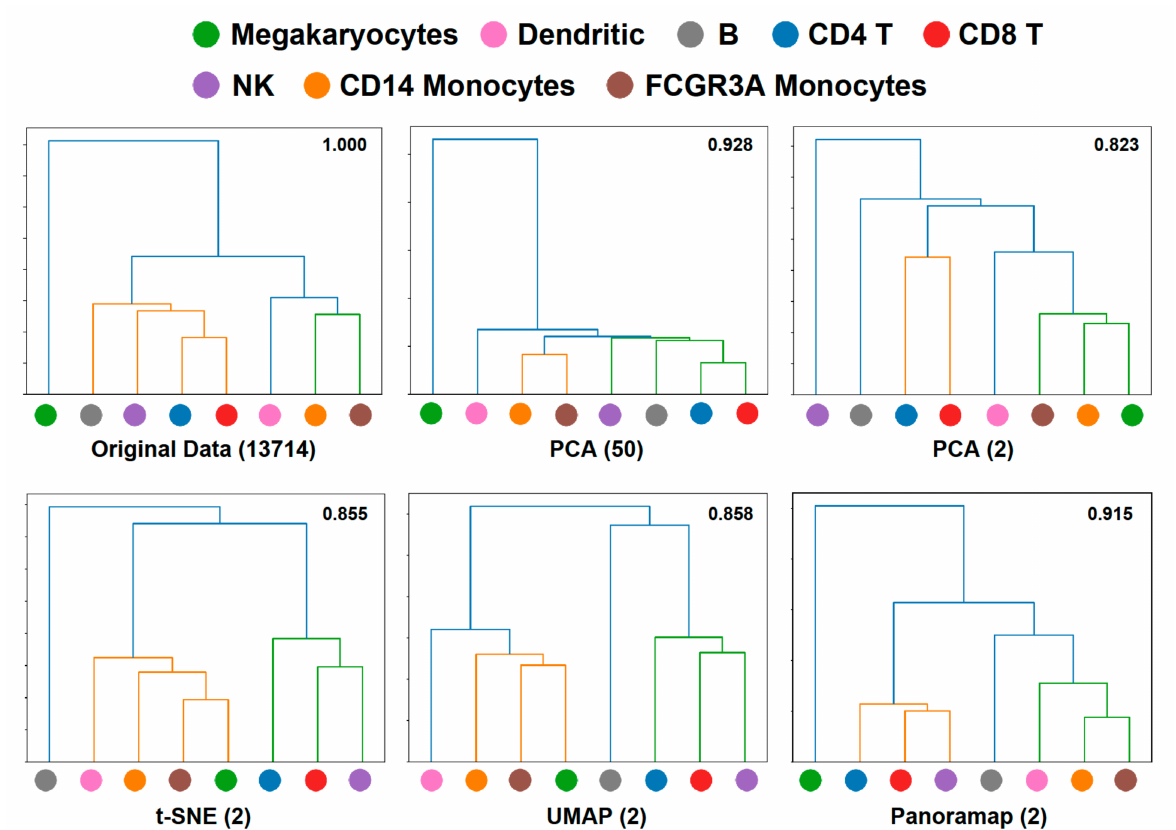
Figure 4. Dendrogram confirms that Panoramap embedding is in accordance with cell lineage or hierarchy. Dendrograms from PBMC3k dataset in the original 13714-dimensional high dimensional space, the 50-dimensional PCA spaces, 2-dimensional PCA space, t-SNE, UMAP and Panoramap embedding spaces using Euclidean distances. The numbers on the upper right corner of each dendrogram denote similarity scores [36] compared with that from original space. Similarity score is between 0 and 1. High similarity score indicates more similarity between compared